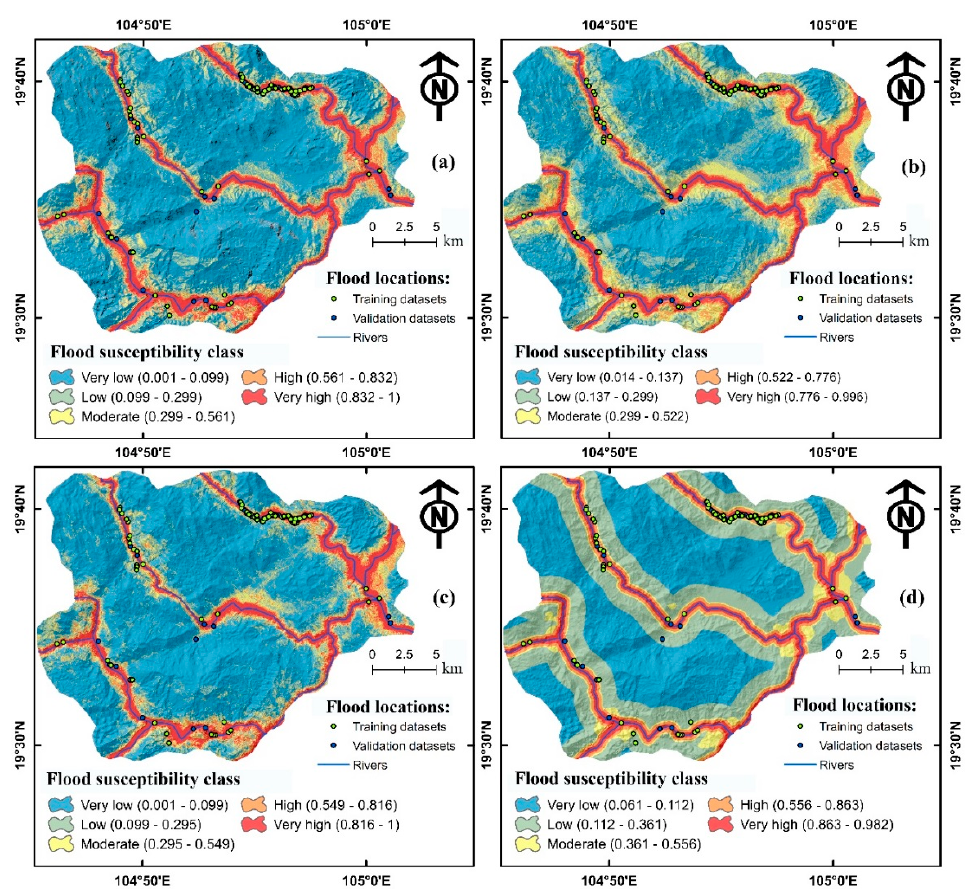
Figure 7. Flood susceptibility maps using various models: ( a ) KLR, ( b ) RBFC, ( c ) NBM, ( d ) LMT.